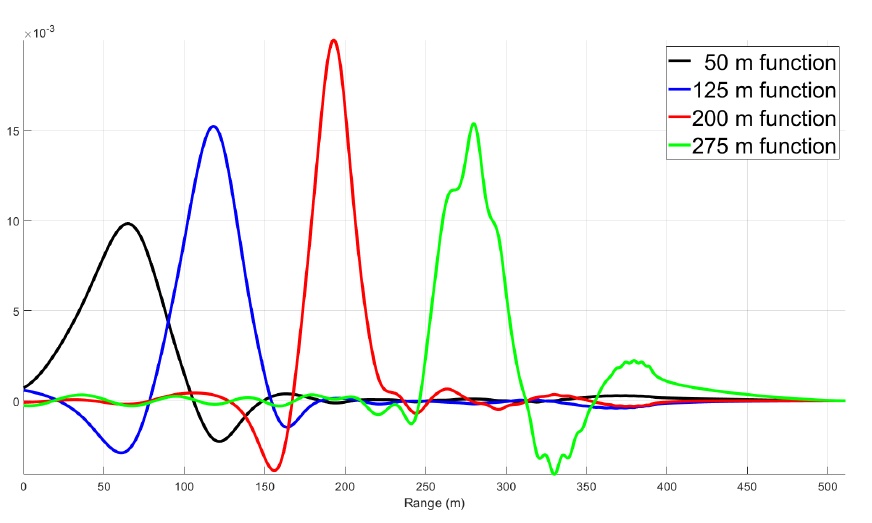
Figure 7. The influence function at 50 m, 125 m, 200 m, and 275 m. The function breaks down past the final weighting function notch near 350